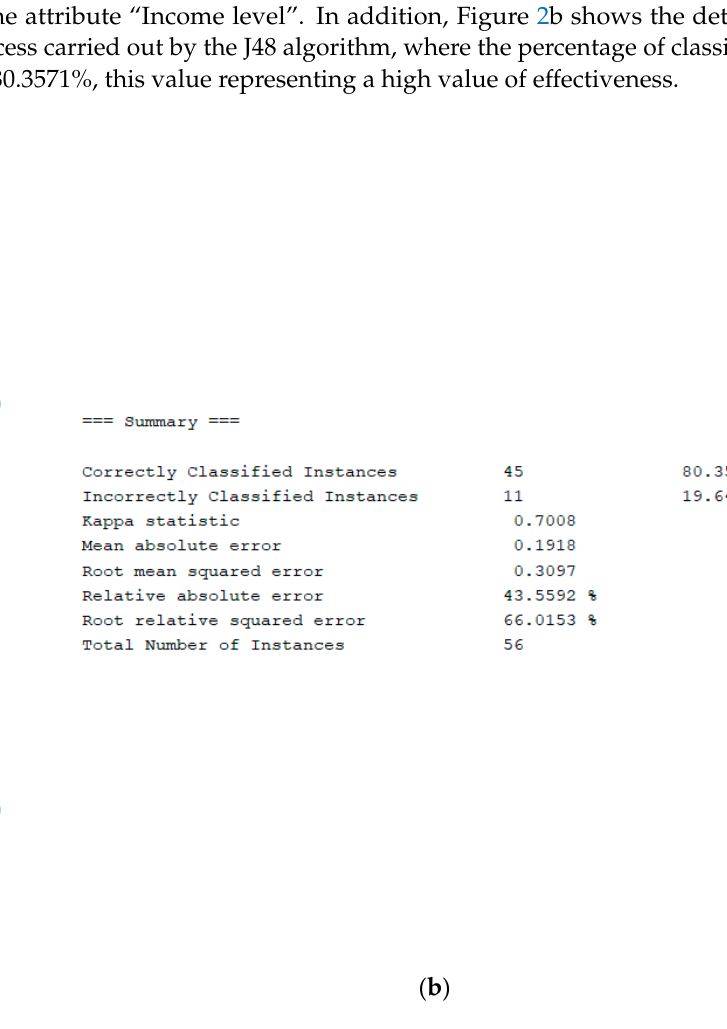
Figure 2. This figure presents the data obtained from the analysis of the data by the algorithm J48. ( a ) Tree generated by in the processing of learning in relation to economic problems; ( b ) description of correct and incorrect classification instances and error values.